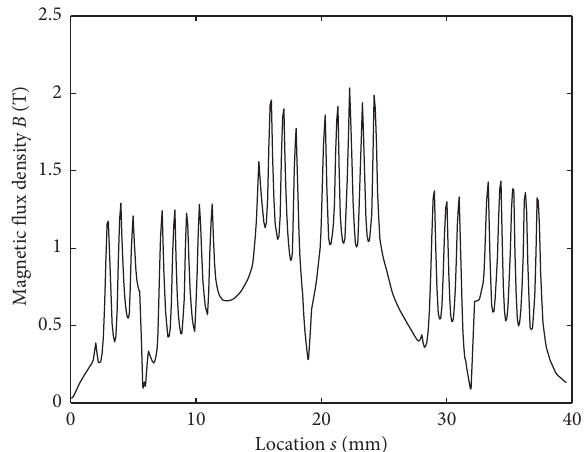
Figure 3: Magnetic field distribution.